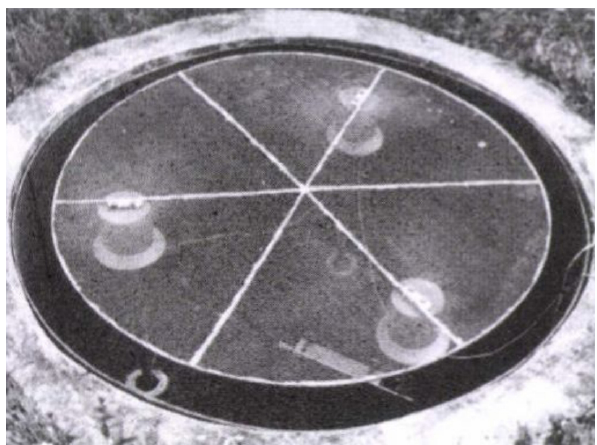
Figure 17. Collector screen for the measurement of the vertical current. (Re-printed from Bencze, 2007, Fig. 3.)